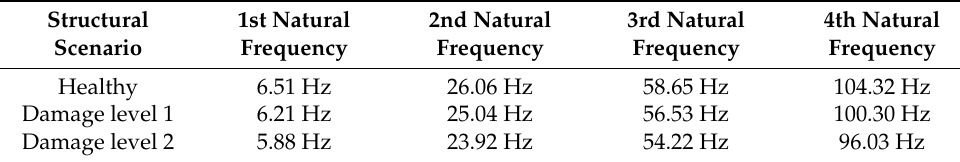
Table 1. Variation of the numerical beam eigenfrequencies.